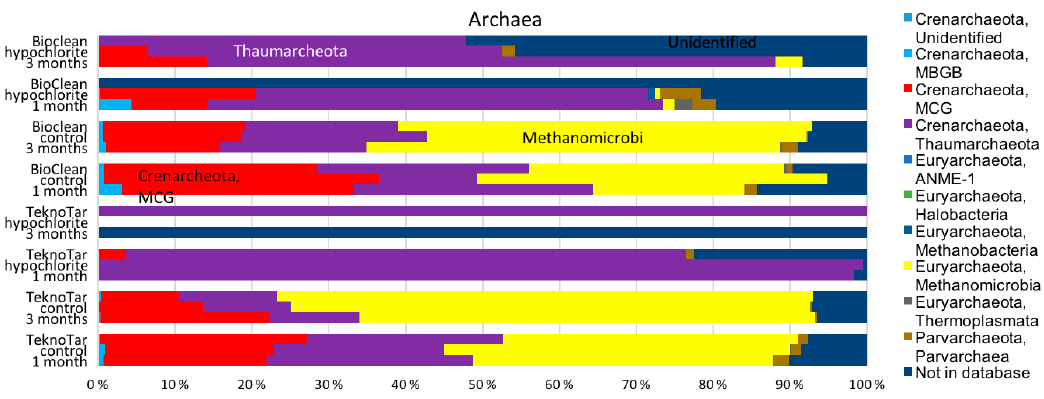
Figure 9. The archaeal community composition on surfaces of BioCleanEco coating and TeknoTar coating in hypochlorite ‐ treated cooling water system and in control system.